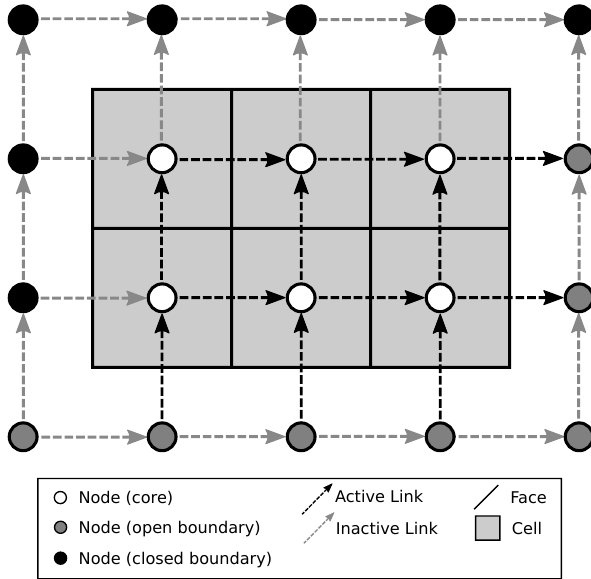
Figure 4. Example of a simple Landlab raster grid, illustrating open- and closed-boundary nodes, and active and inactive links.